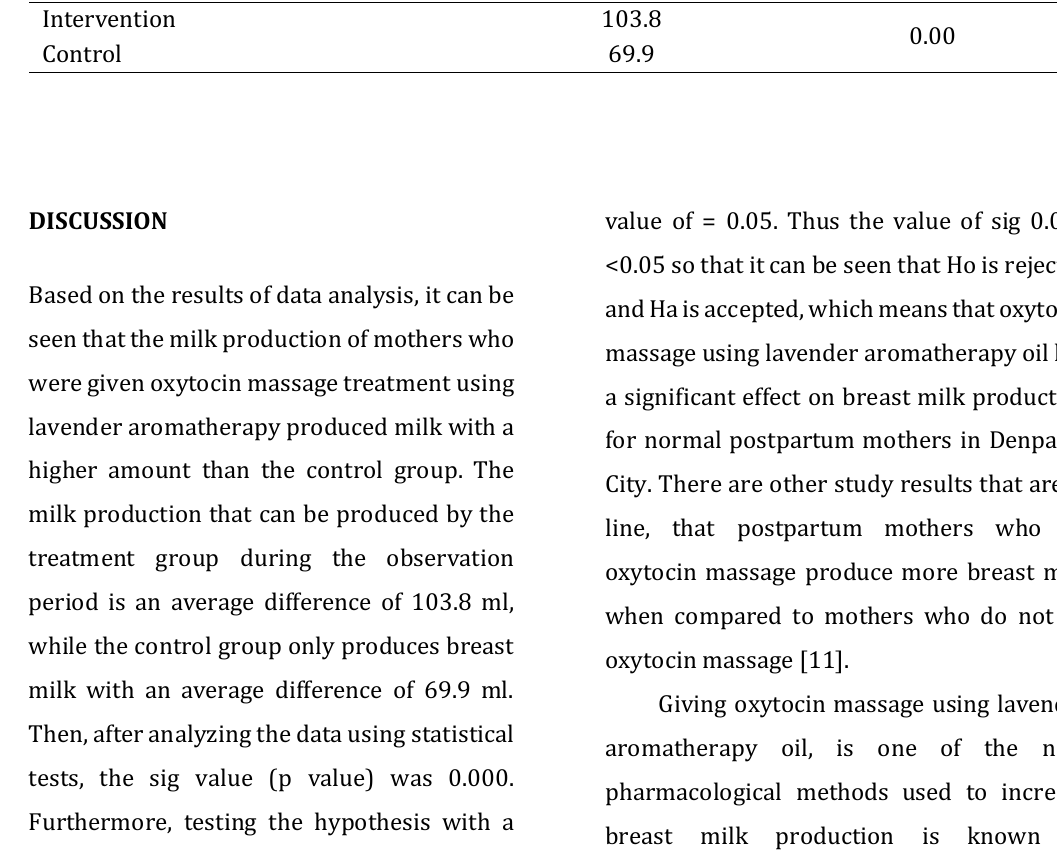
Effect of Oxytocin Massage using Levender Aromatherapy Oil on Breast Milk Production in Postpartum Group